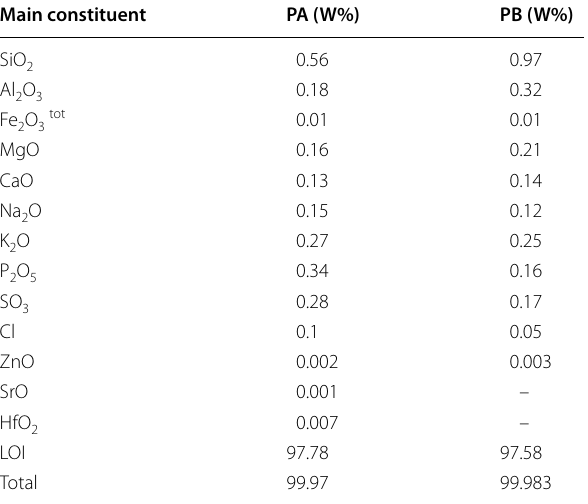
Table 3 Chemical analysis of the two contaminated peanut samples